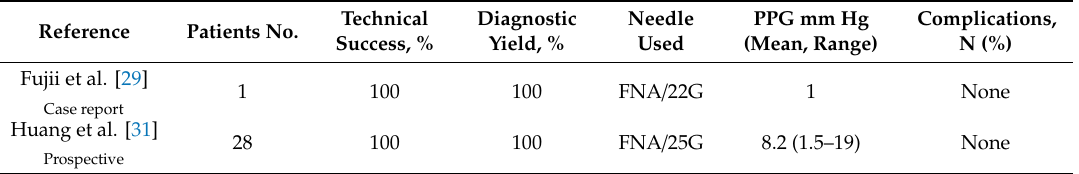
Table 1. Human studies reporting the utility of EUS-guided portal hypertension